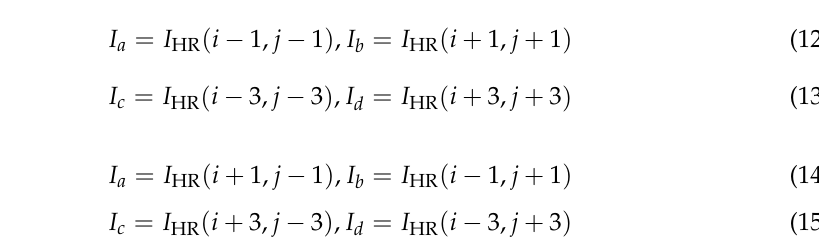
Figure 8. PSNR results averaged for 12 test images for different values of ω . I represents the gray value of the pixel to be interpolated; I a , I b , I c , and I d represent four known pixel values around the unknown pixel, and their values depend on the properties of the unknown pixel. The specific process is as follows [20].